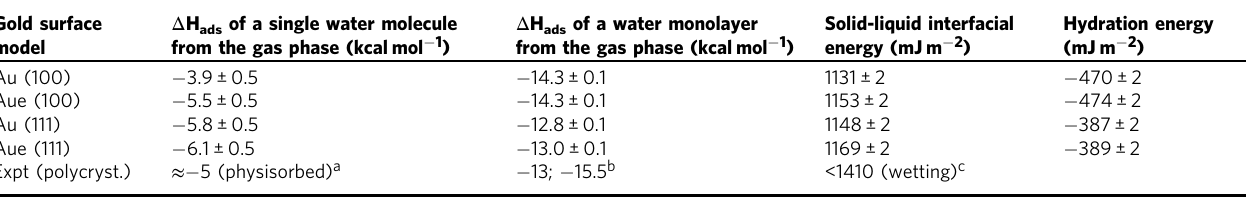
Table 2 Detailed properties of gold-water interfaces according to computation with the polarizable force fi eld in comparison to the nonpolarizable force fi eld (Lennard – Jones only model) and experimental data Gold surface